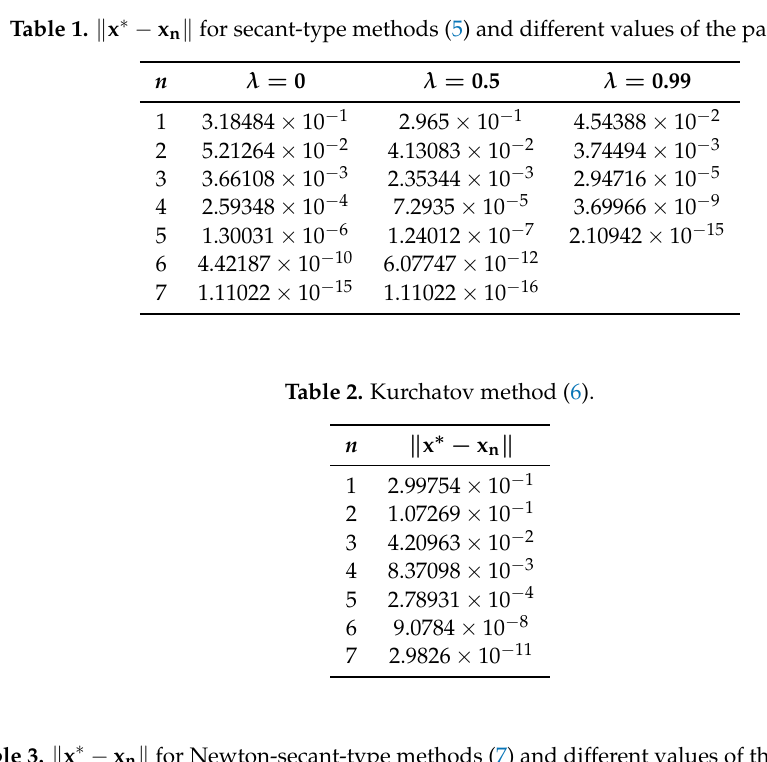
Table 3. (cid:107) x ∗ − x n (cid:107) for Newton-secant-type methods (7) and different values of the parameter λ .